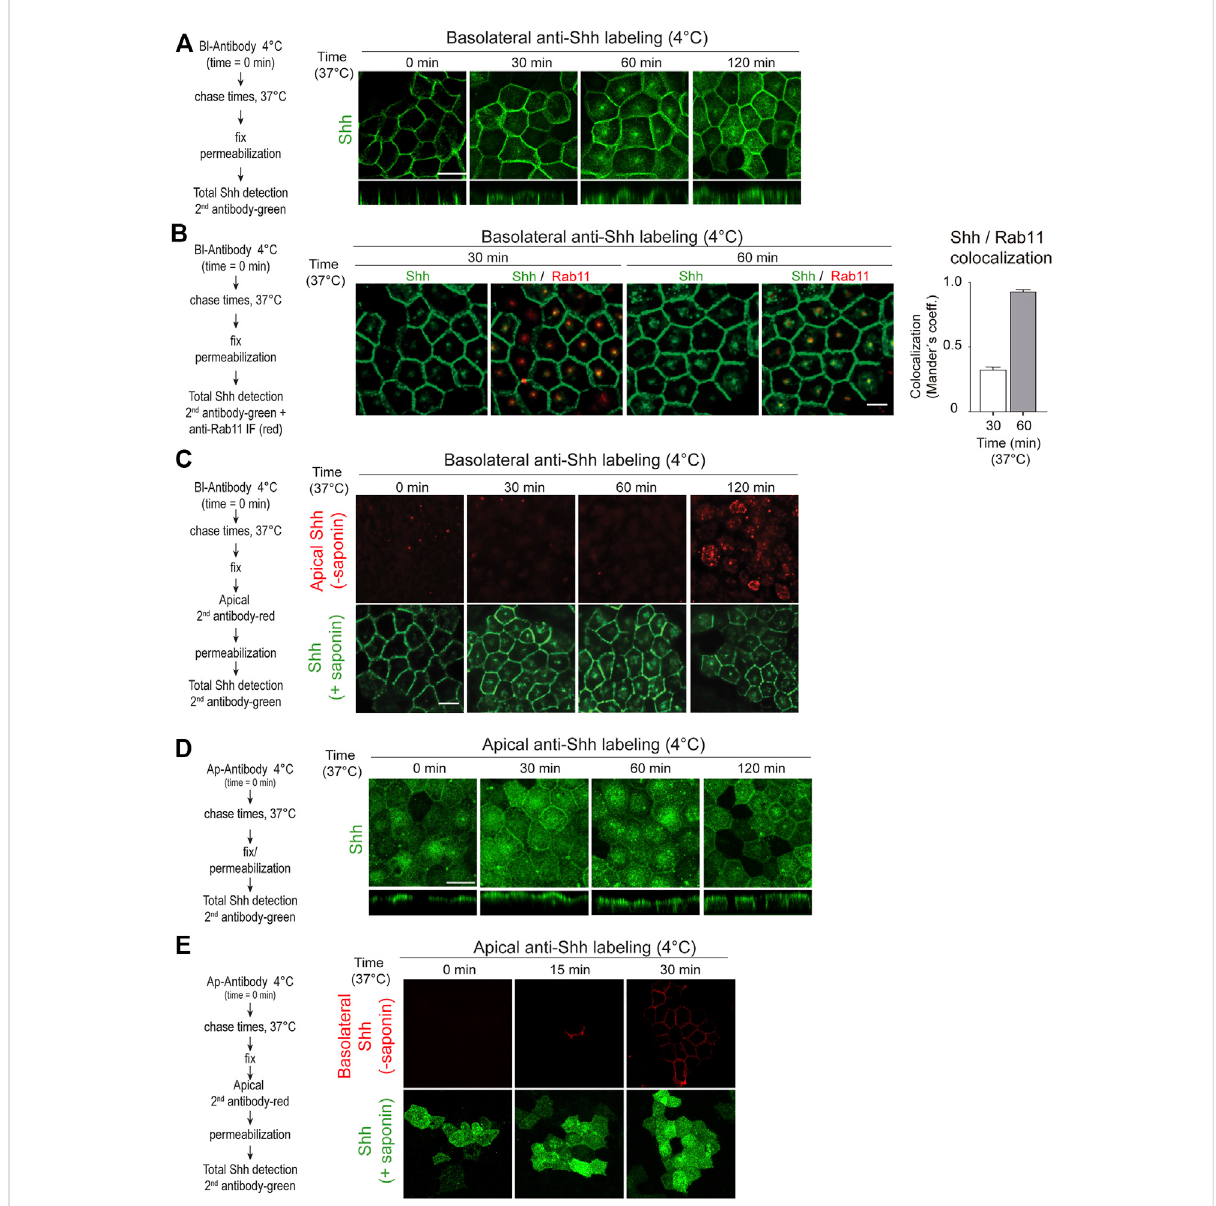
FIGURE 3 Shh transcytosis. Polarized MDCK-Shh cells in Transwell fi lters were incubated with anti-Shh antibodies at 4 ° C from the basolateral (A – C) or apical (D , E) sides,shiftedto 37 ° C fortheindicatedtimes, anddetectedbythesecondaryantibody. (A) Antibody-tagged basolateralShhmoved tothe apical domain including a subapical punctate compartment, as shown by the secondary antibody (green) added after permeabilizing the cells at the indicated time points. (B) Shh (green) colocalization with endogenous Rab11 (red) after 30 and 60 min of traf fi cking. Graph shows the percentage of Rab11 colocalizing with Shh (mean ± SEM, n = 15 cells, unpaired t -test *** p < 0.001. (C) Apical cell surface detection of antibody- tagged basolateral Shh. Secondary antibody (red) was added to the apical side of non-permeabilized cells, which then were permeabilized and incubated with another secondary antibody (green). (D) Antibody-tagged apical Shh moved to the basolateral domain, as shown by total staining of permeabilized cells. (E) Basolateral cell surface detection of antibody-tagged apical Shh. Secondary antibody (red) was added to the basolateral side of non-permeabilized cells, which then were permeabilized and incubated with another secondary antibody (green). Scale bar, 10 μ